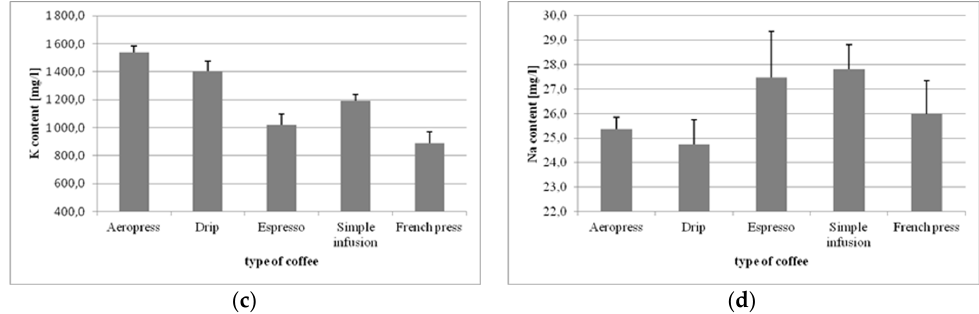
Figure 3. Concentrations of P ( a ), Si ( b ), K ( c ), and Na ( d ) in coffee beverages made using different methods.